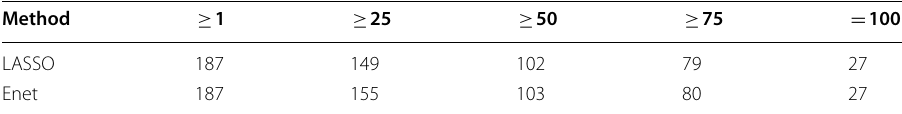
Table 2 Selection counts of LASSO and Enet